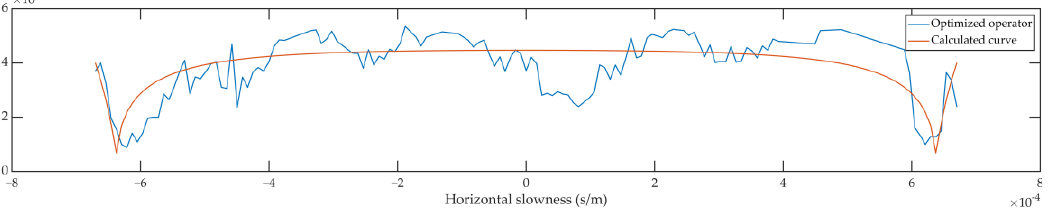
Figure 9. Property estimation by least-squares curve-fitting. The blue curve denotes the values di- rectly given by the optimization procedure (some outlier removal algorithms are applied). The or- ange curve denotes the fitted curve calculated using the inverted elastic parameters.